Question: Identify the chart type used in this figure.
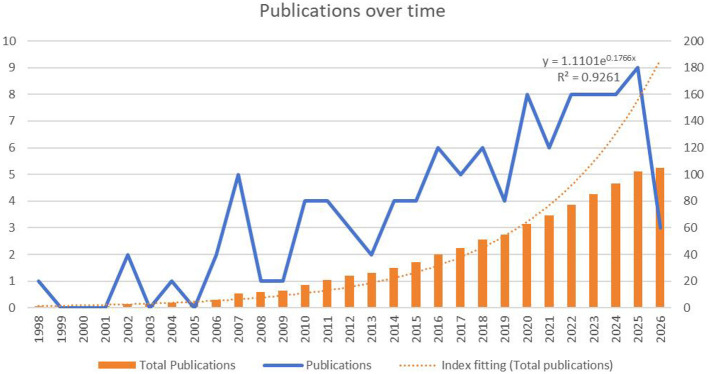
Answer: bar